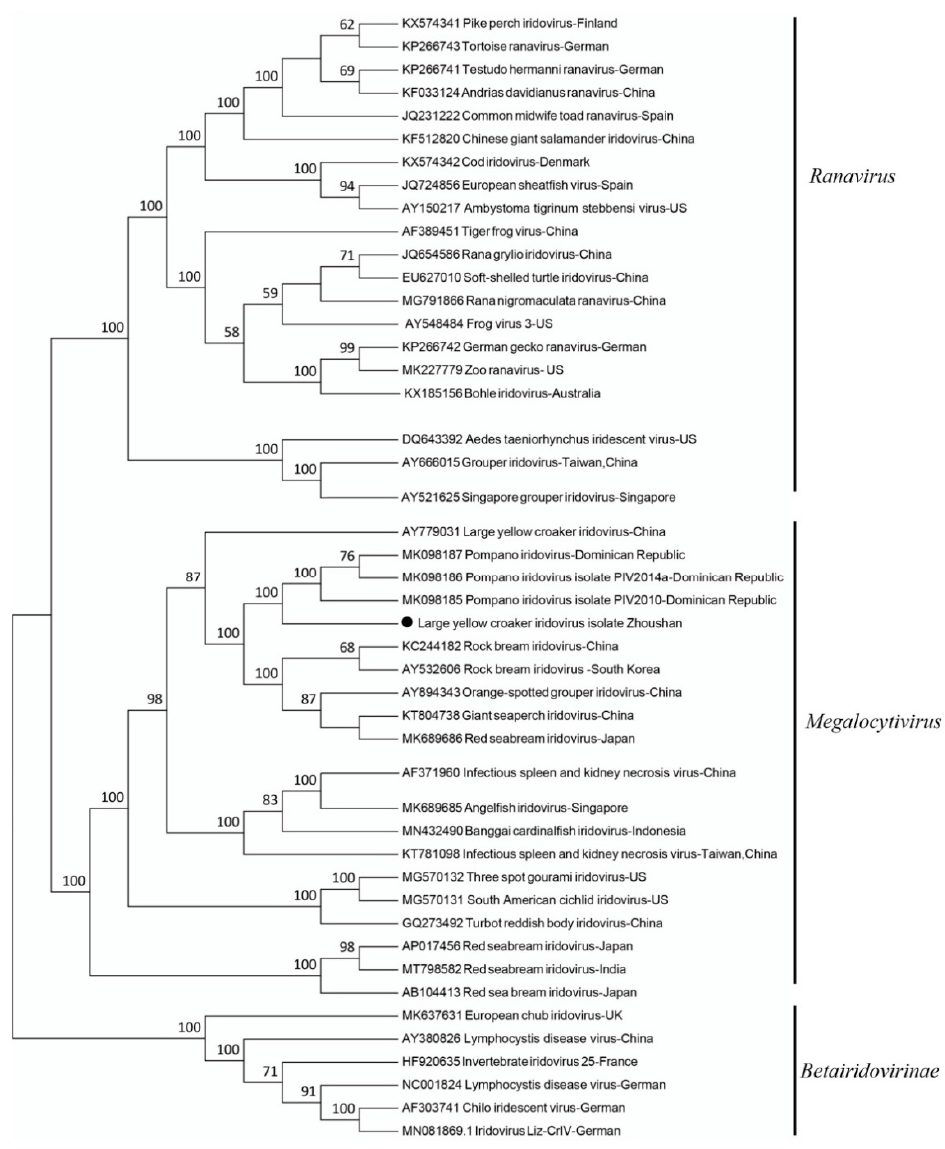
Figure 3. Phylogenetic analysis of LYCIV-ZS-2020 and the other representative iridoviruses based upon nucleotide sequences of the full-length genome. The tree was constructed by the neighbor- joining method. Bootstrap values are indicated for each node from 1000 resamplings. The names of the viruses, GenBank accession numbers, and locations are shown. The solid black circle indicates the LYCIV-ZS-2020 reported in this study.